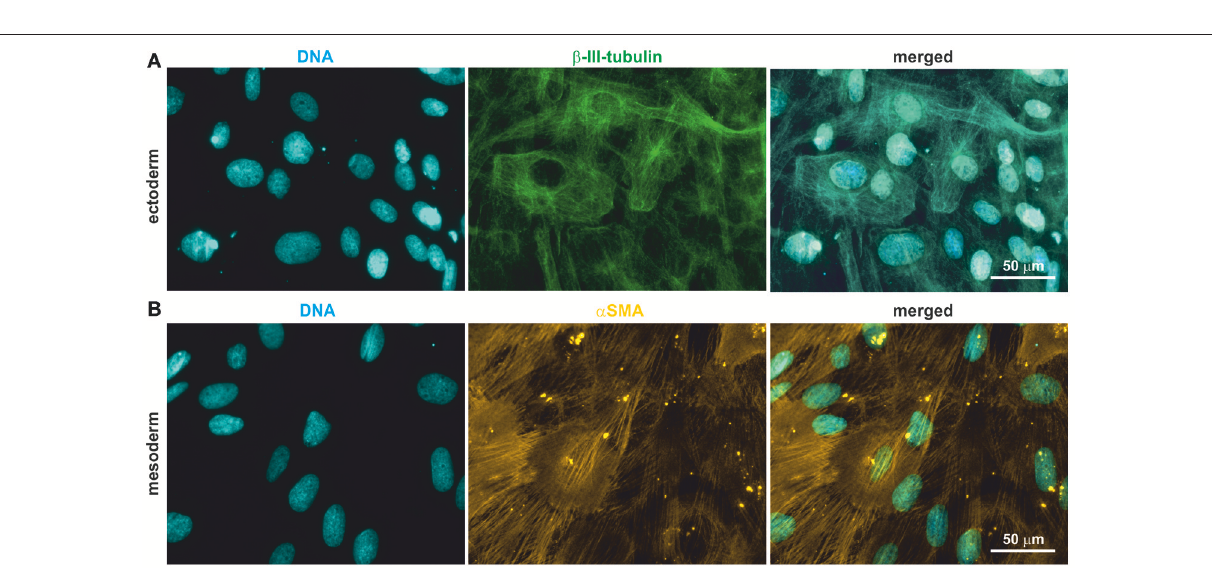
We successfully isolated ovine palatal NCSCs from the hard palate and were able to cultivate them as free floating